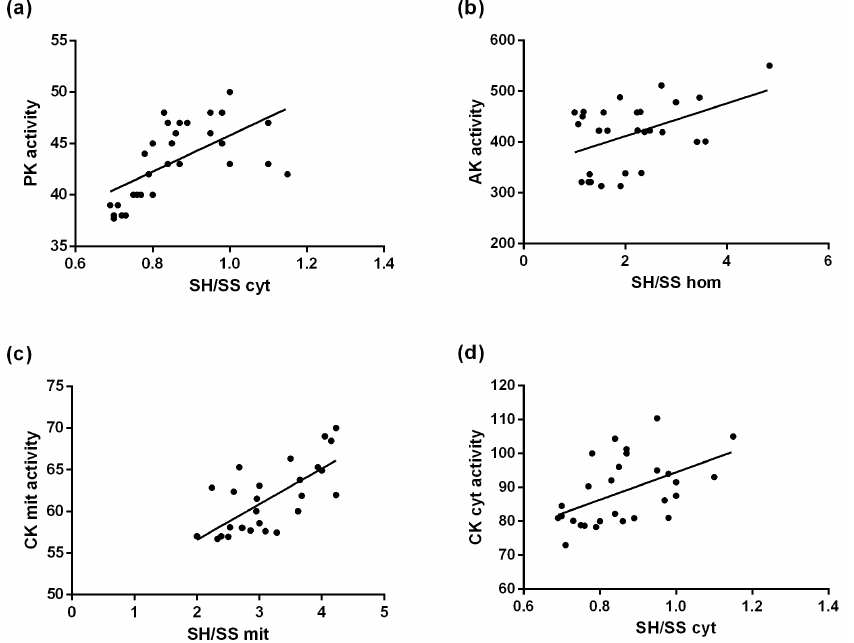
Figure 2 - Linear regression between SH/SS ratio ( a ) in the cytosolic fraction and PK activity. ( b ) in the hole homogenate (hom) and AK activity. ( c ) in the mitochondrial fraction and CK mit activity. ( d ) in the cytosolic fraction and CK cyt activity. (n=7 animals per